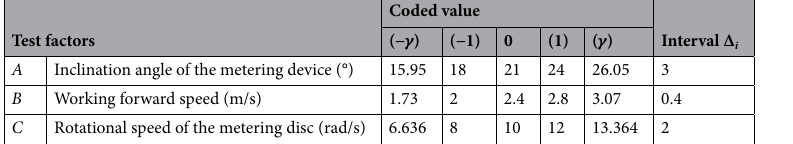
Table 3. Factors and levels of a virtual